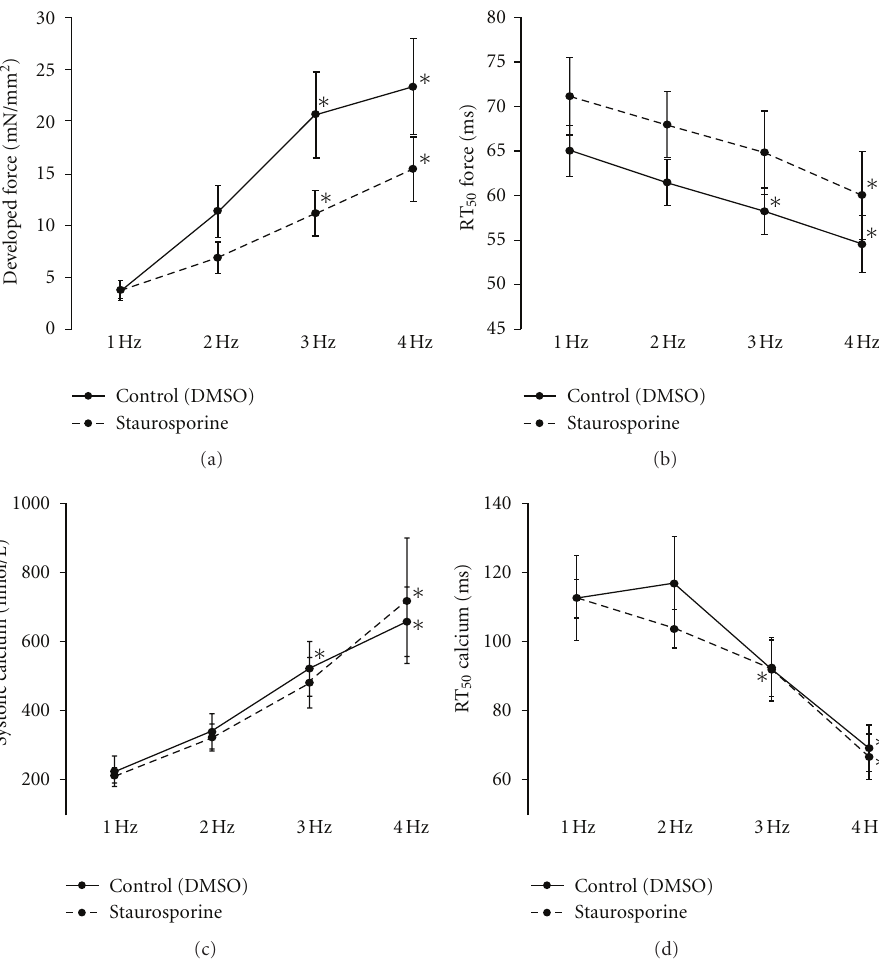
Figure 2: Average twitch and calcium transient data from trabeculae treated with staurosporine or vehicle (DMSO) ( n = 8 for each group). Panels (a) and (b) show the developed force (a) and relaxation time to 90% of peak (RT 50 ) at each frequency 1 through 4 Hz. Analysis by two-way ANOVA (Bonferroni correction, P < 0 . 05) showed that frequency significantly altered force and relaxation, but staurosporine did not significantly alter the FFR or FDAR. Panels (c) and (d) show the average systolic calcium levels (c) and time constant of calcium decline (tau). There was no significant e ff ect of 100 nM staurosporine, nor an interaction between staurosporine and frequency. The e ff ect of frequency within each group was analyzed by one-way AVOVA ( ∗ significantly di ff erent from